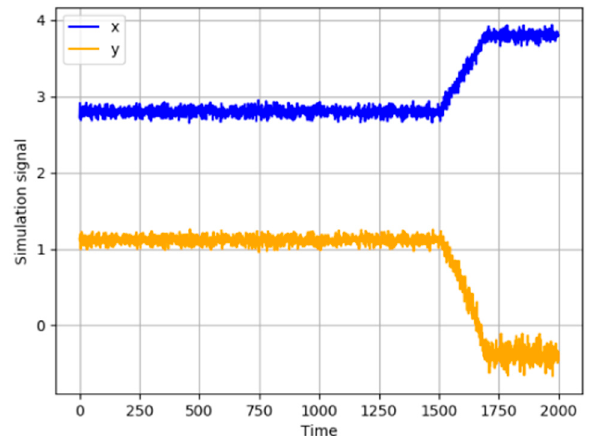
Figure 4. Original data of the simulation signal.